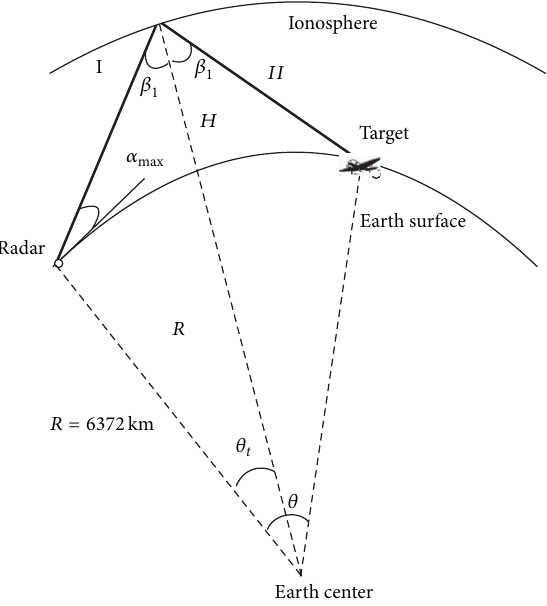
Figure 18: The illustration of the minimum detection range of the skywave